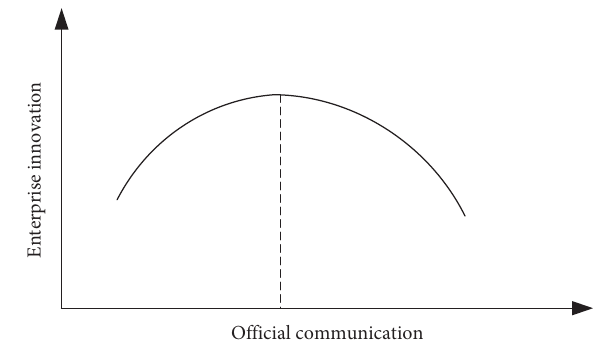
Figure 2: Relationship between official communication and en- terprise